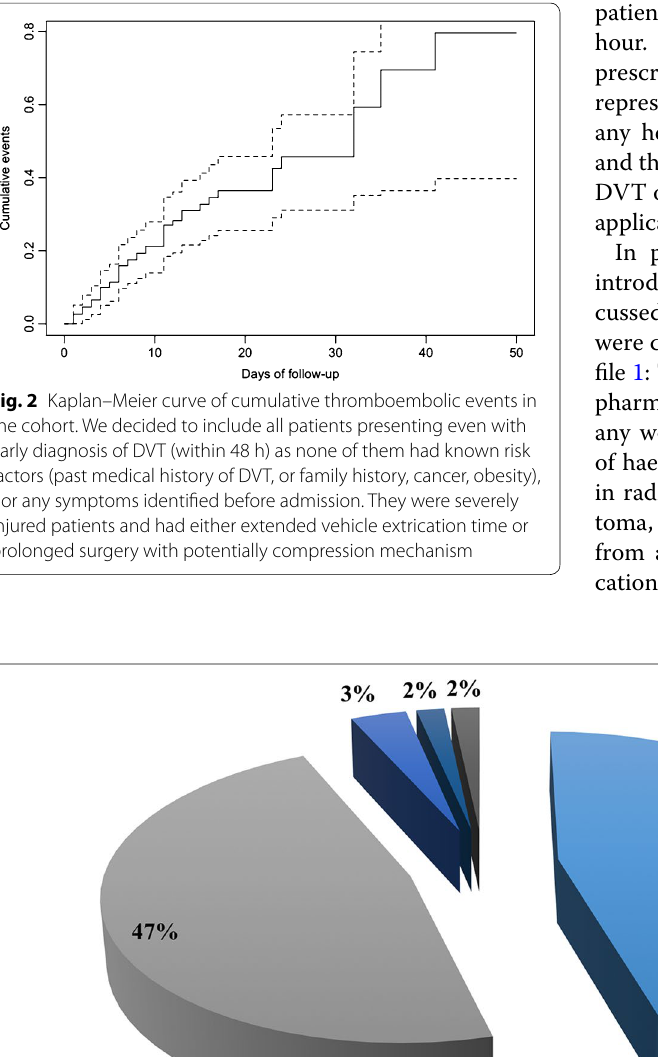
59 in 45 patients). Femoral ( n =